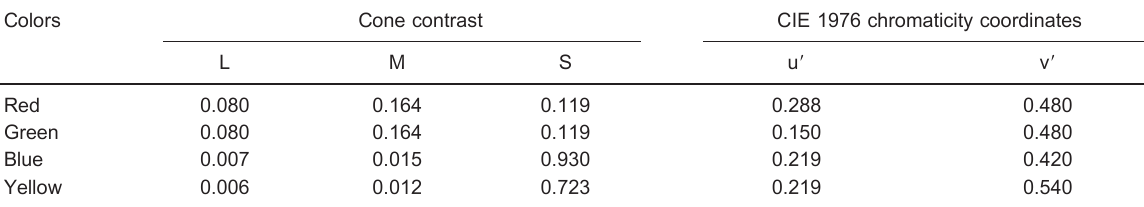
0.006 Values are for the maximum contrast used. For each cone type the cone contrast was calculated according to the ratios L = l b - l / l b , M = m b - m / m b , and S = s b - s / s b , where l b , m b , s b , l, m, and s are cone excitation values for background and target, color are shown in Table 1 for the maximum chromatic contrast.